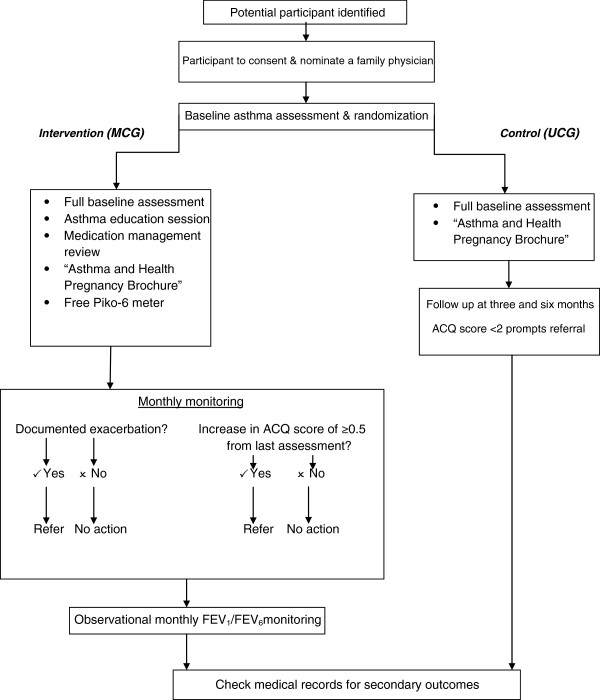
MAMMA© study design.